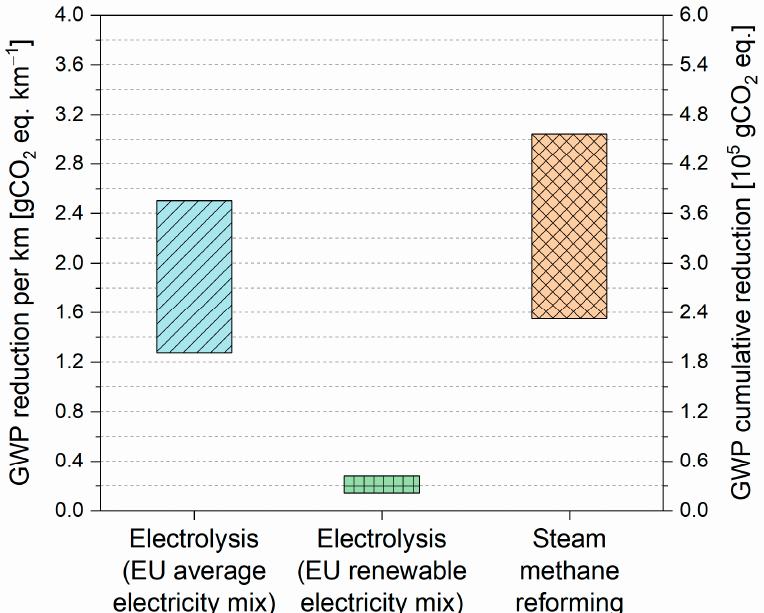
Figure 3. Global warming potential reduction per km (left y -axis) and over the entire life cycle (right y -axis) when substituting PTFE- with FEP-based GDMs in an FCEV. The reduction is calculated as the difference between the GWP for the PTFE-based FCEV and the GWP for the FEP-based FCEV. Floating bars represent the range of values obtained for each production pathway by varying the initial fuel consumption and the cell power densities.